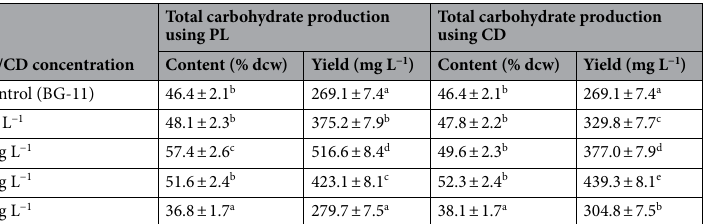
Total carbohydrate production using PL